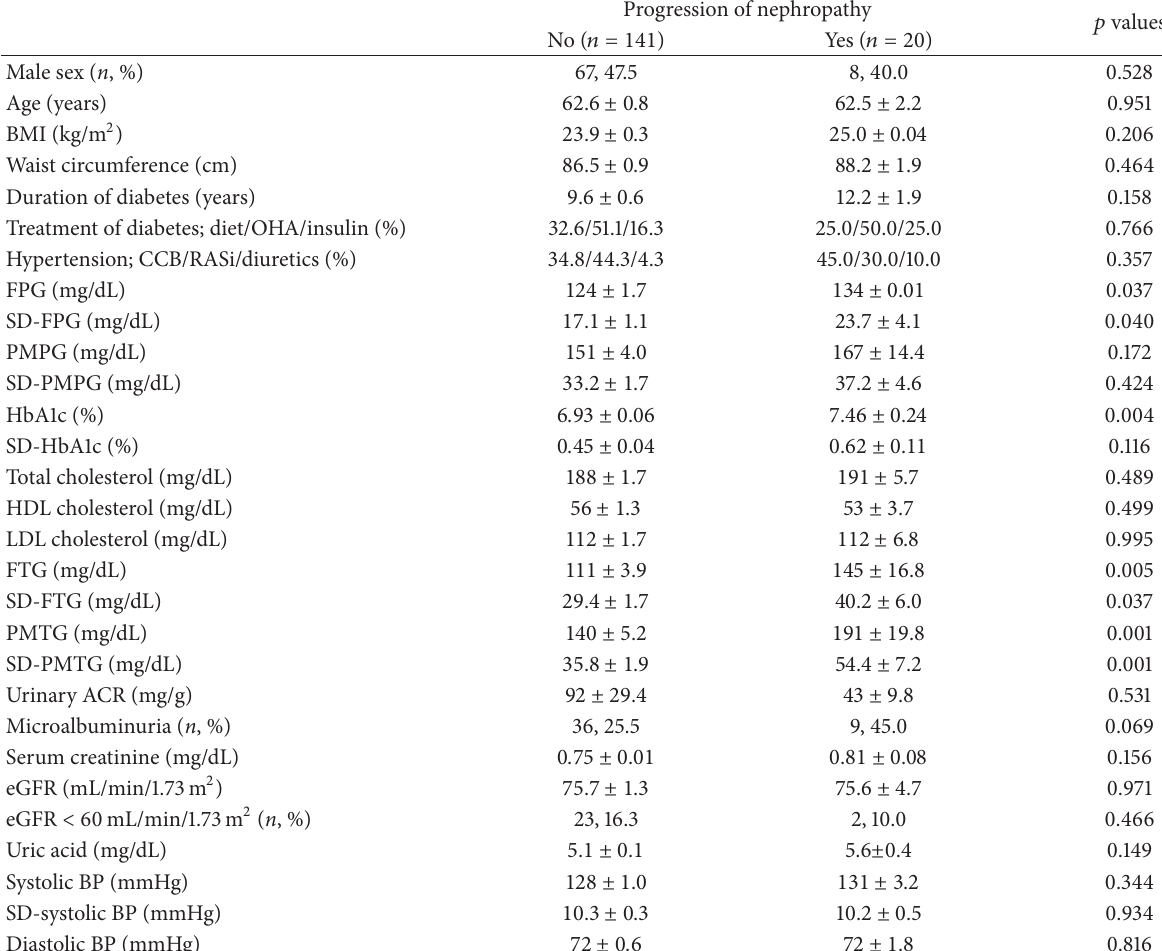
Table 1: Characteristics of patients with progression of diabetic nephropathy.